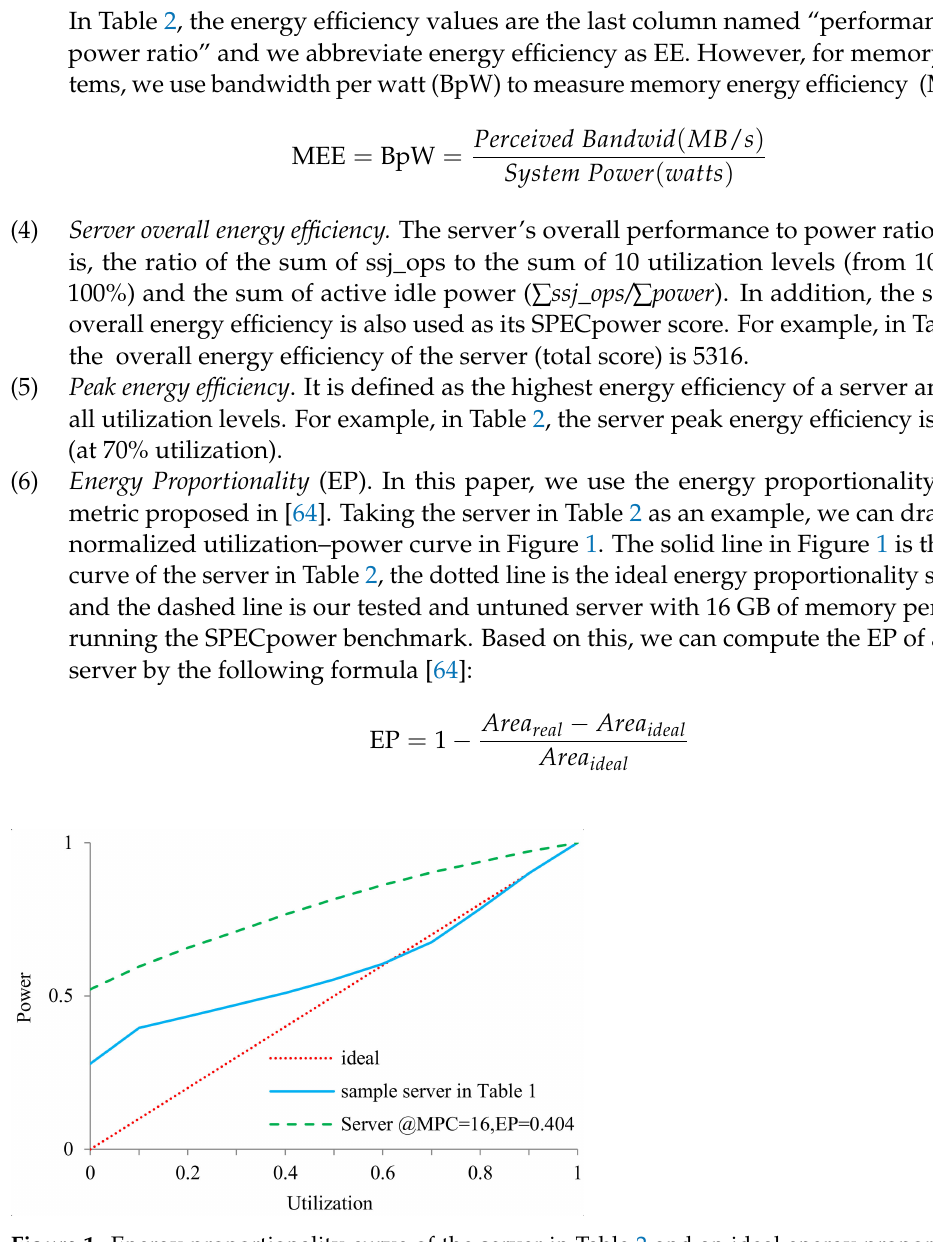
Figure 1. Energy proportionality curve of the server in Table 2 and an ideal energy proportional server (power normalized to power at 100%